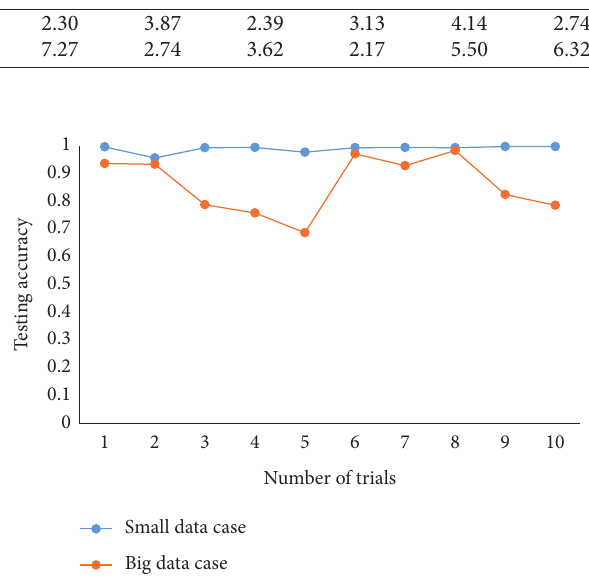
Figure 13: Accuracy of W-CONV with different data cases. Table 8: Computational times of each model.